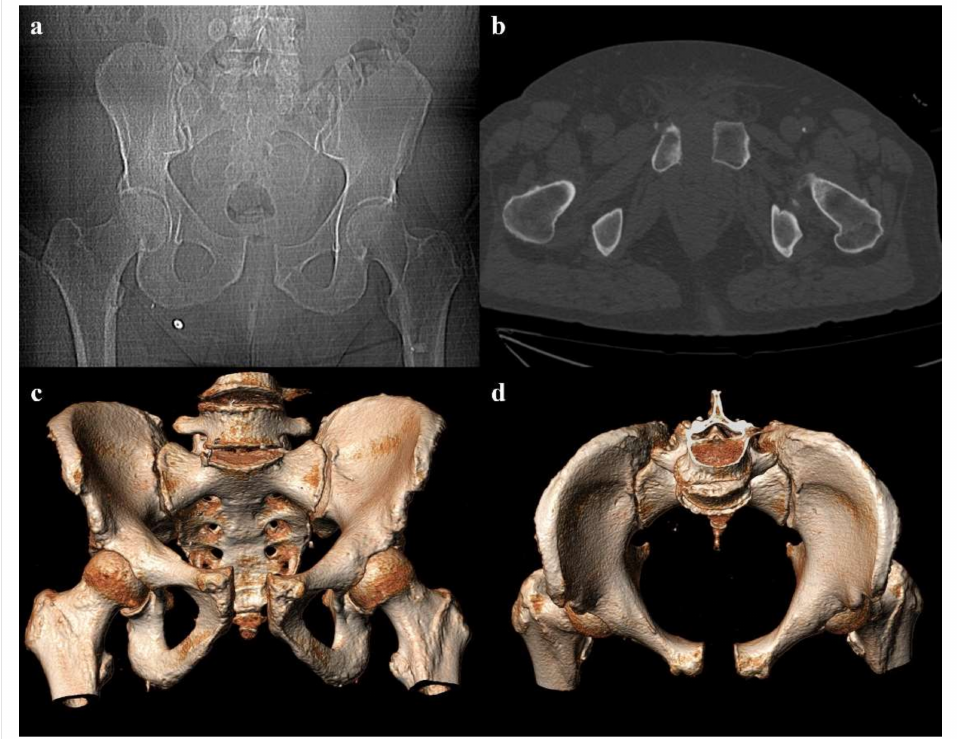
Figure 4. Anterior–posterior compression fracture, type 1. Anteroposterior scout CT view ( a ) and axial CT image ( b ) show a 2.4 cm diastasis of the pubic symphysis. Three-dimensional volume- rendering CT reconstructions in outlet and inlet views ( c , d ) well depict the